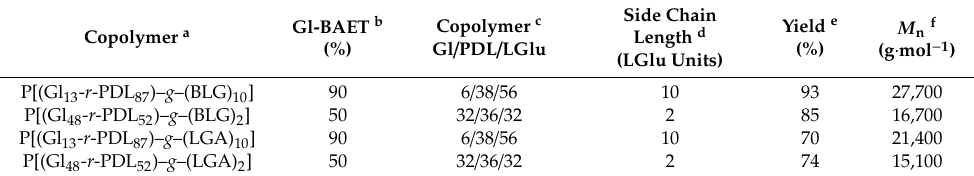
Table 3. P[(Gl x - r -PDL y )– g –(LGlu) z ] copolymers: composition and molecular